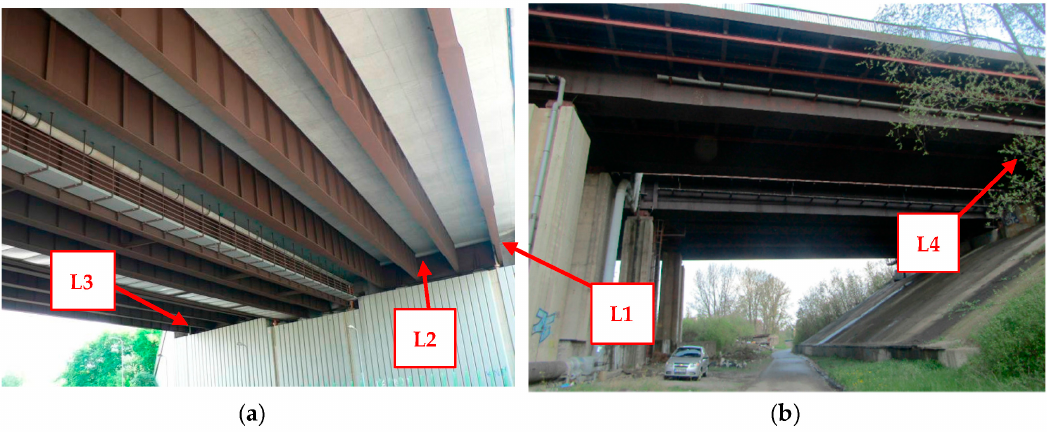
Figure 6. Position of the measuring devices on the selected bridge structures—bridge No. 1 ( a ) and bridge No. 2 ( b ).